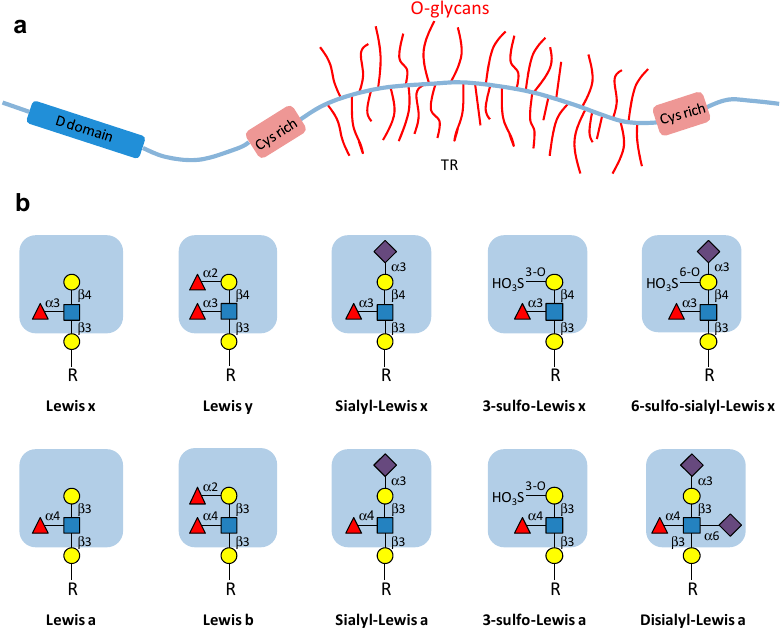
Figure 1. ( a ) Schematic drawing of a secretory mucin type glycoprotein constituted by a MUC protein backbone (apomucin) carrying numerous O -glycans attached to Thr or Ser residues contained in the variable number of tandem repeat (TR) domains. Cysteine-rich (Cys rich) domains at the ends of the